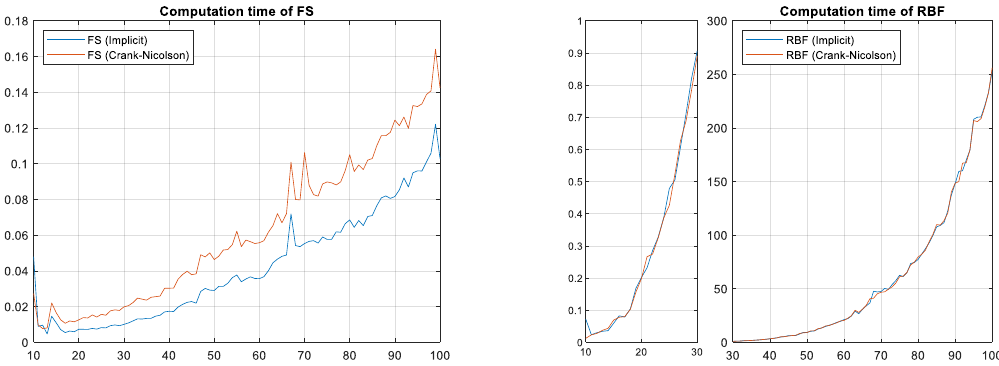
Figure 3. Computation time (in seconds) with respect to the number of partitions of space dimensions for the fractional step method (FS) ( Left ) and the radial basis functions (RBF) ( Right ).